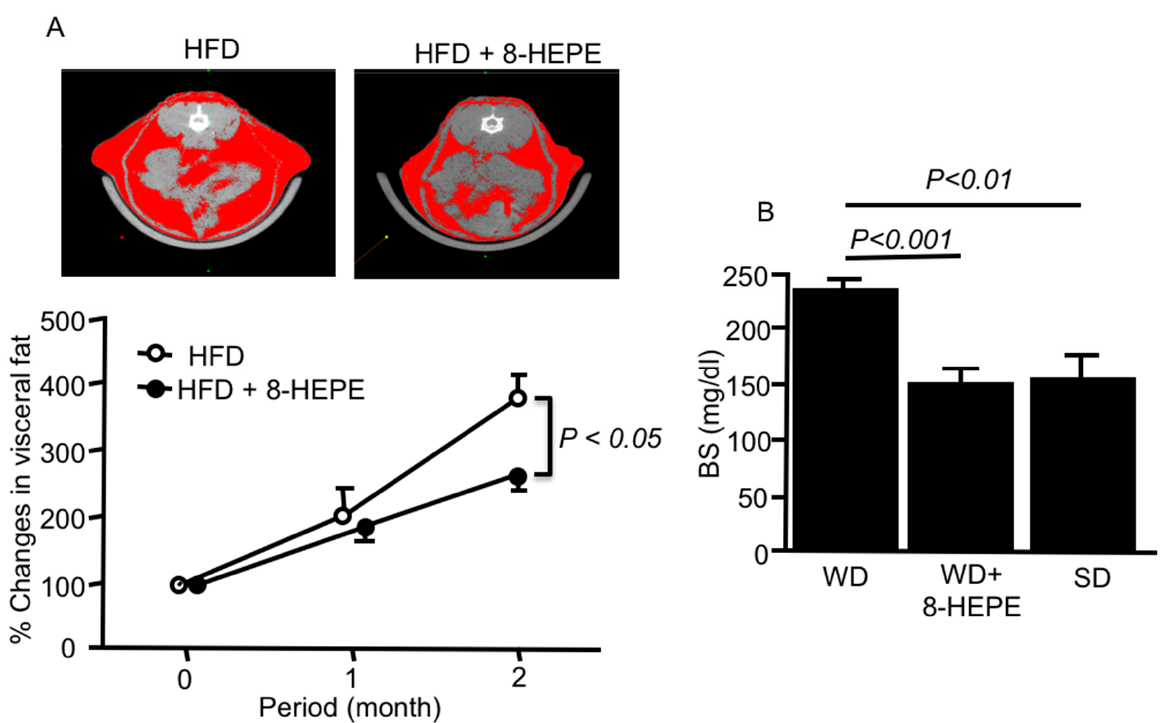
Figure 2. ( A ) Representative computed tomography images of the abdomen (upper) and percentage changes in visceral fat area (lower) in mice fed an HFD only or an HFD with 8-HEPE. Visceral and subcutaneous fat areas are shown in red. Data are the mean ± SE obtained from eight mice for each group. ( B ) Blood sugar (BS) in apoE knock-out (apoE-KO) mice fed a WD only or WD with 8-HEPE. Data are the mean ± SE obtained from 10 mice for each group. An analysis of variance (ANOVA) with Dunnett’s test was used for the statistical analysis. HFD, high fat diet; 8-HEPE, 8-hydroxyeicosapentaenoic acid; WD, western diet.